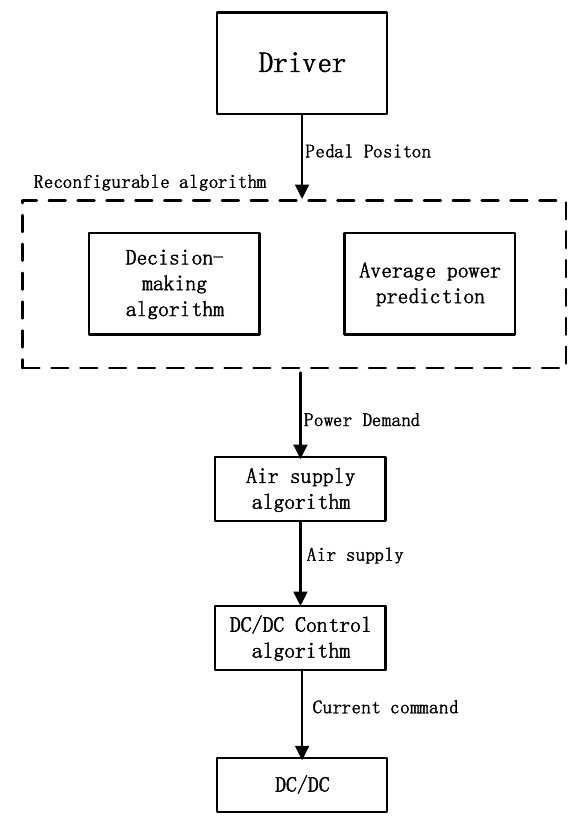
Figure 9. Air supply control order.